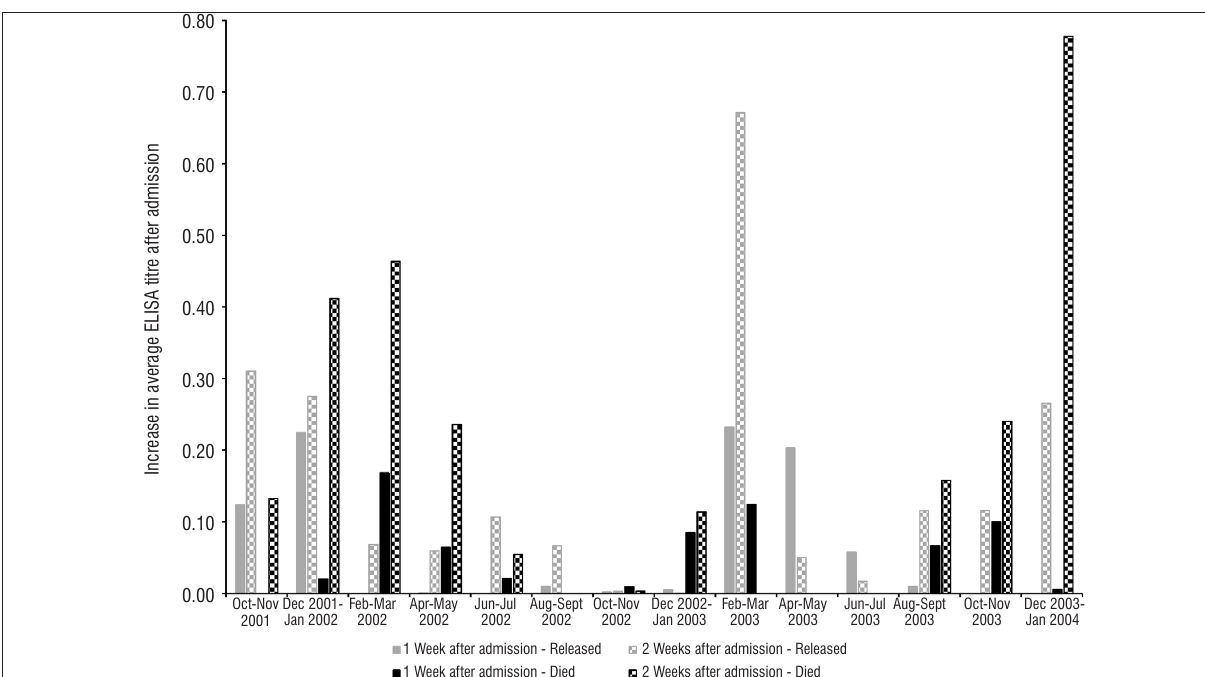
Figure 2: Increases in anti- Plasmodium antibody levels of penguins that were released compared with those that died after entry into the SANCCOB facility: ‘1 Week after admission’ represents the difference in average ELISA titre values from Week 0 to Week 1; ‘2 Weeks after admission’ represents the difference in average ELISA titre values from Week 0 to Week 2. No deaths were recorded during April–May 2003. Missing data points for other months reflect no increases in titre